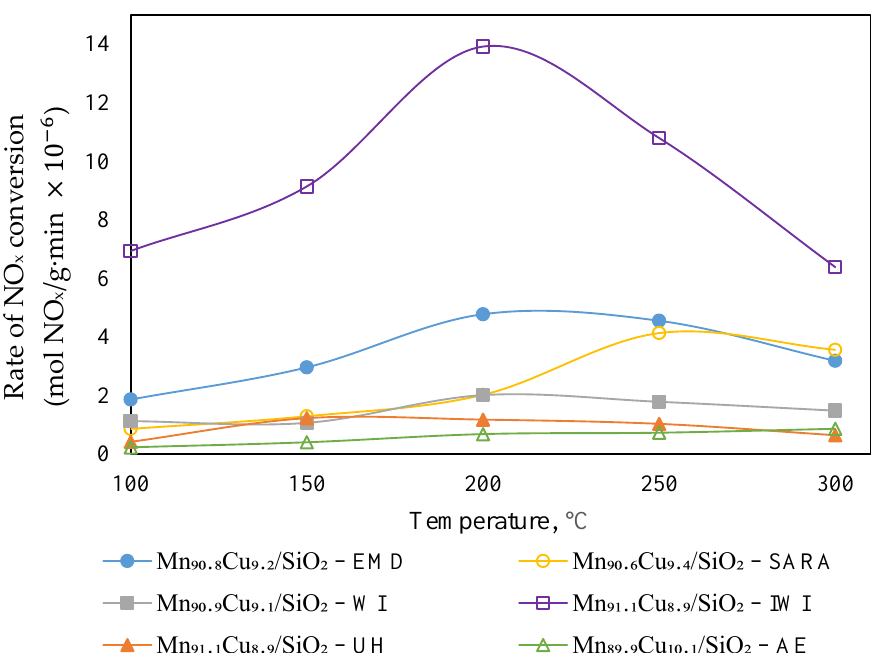
Figure 8. Rate of NO x conversion provided by the Mn–Cu oxide catalysts supported by the silica gel powder related to 1 g of the active species deposited: NO/NH 3 ratio ~1.0; NO ~300–500 ppm, O 2 ~3–5%; volumetric gas flow rate ~0.105 l·min −1 ; GHSV ~450 h −1 ; contact time—8 s.